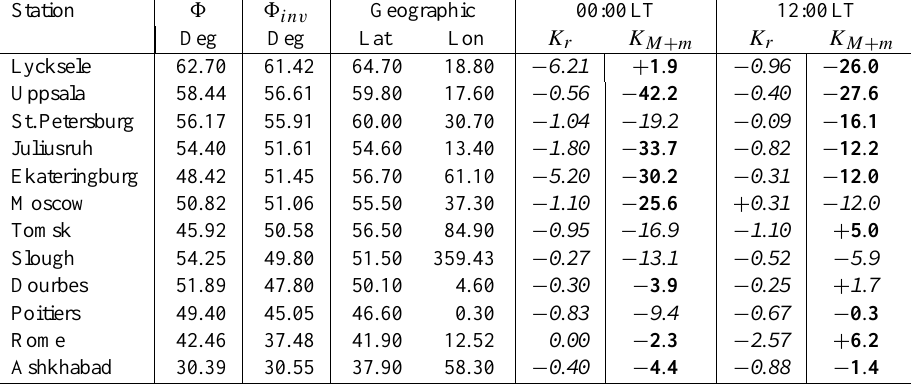
Table 4. Ionosonde stations and calculated slope K r (in 10 − 4 per year) for the period of increasing geomagnetic activity 1965–1991. K M + m values from Mikhailov and Marin (2000) are given for a comparison. Bold face figures for K M + m show significant trends with a confidence level ≥ 90%, italic face figures are trends which are not significant at the 90% confidence level Station